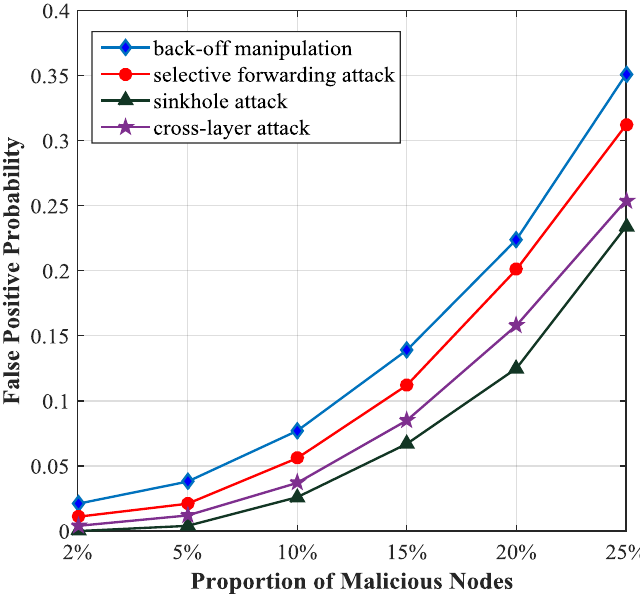
Figure 8. False positive probability with different proportion of malicious nodes .